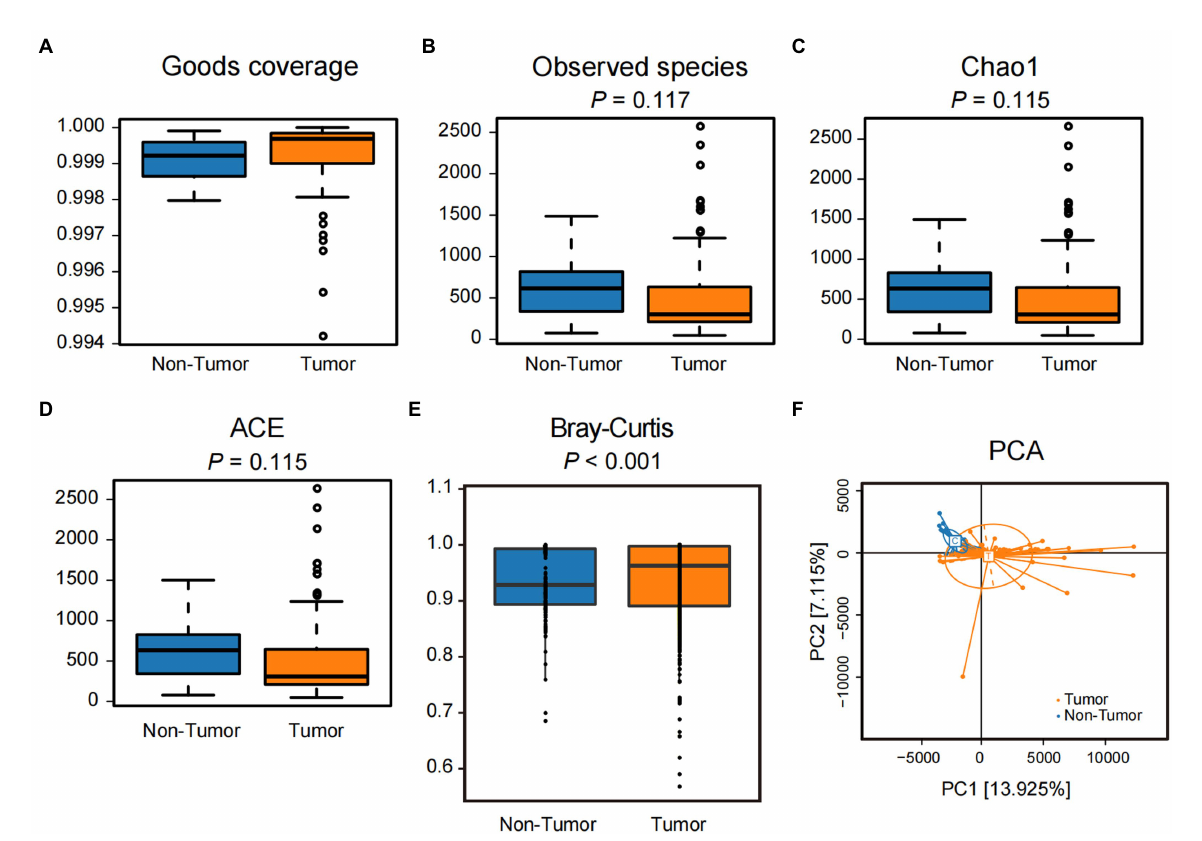
FIGURE 1 Difference analysis of α and β diversities of BALF samples in Tumor and Non-tumor groups. (A) Goods coverage refers to the coverage of the two sample libraries, whose value is close to 1, indicating that the sequencing depth is sufficient. (B) Observed species, number of observed ASVs. (C) Chao1 index, one of the α diversity indicators to measure community richness. The larger the value, the more taxa. (D) ACE index, another α diversity indicator to measure community richness, differs from the algorithm for the Chao1 index. (E) Bray-Curtis distance, one of the quantitative indicators of β diversity among samples. (F) PCA analysis based on ASV abundance and Euclidean distance showed a scattered distribution of samples between the two